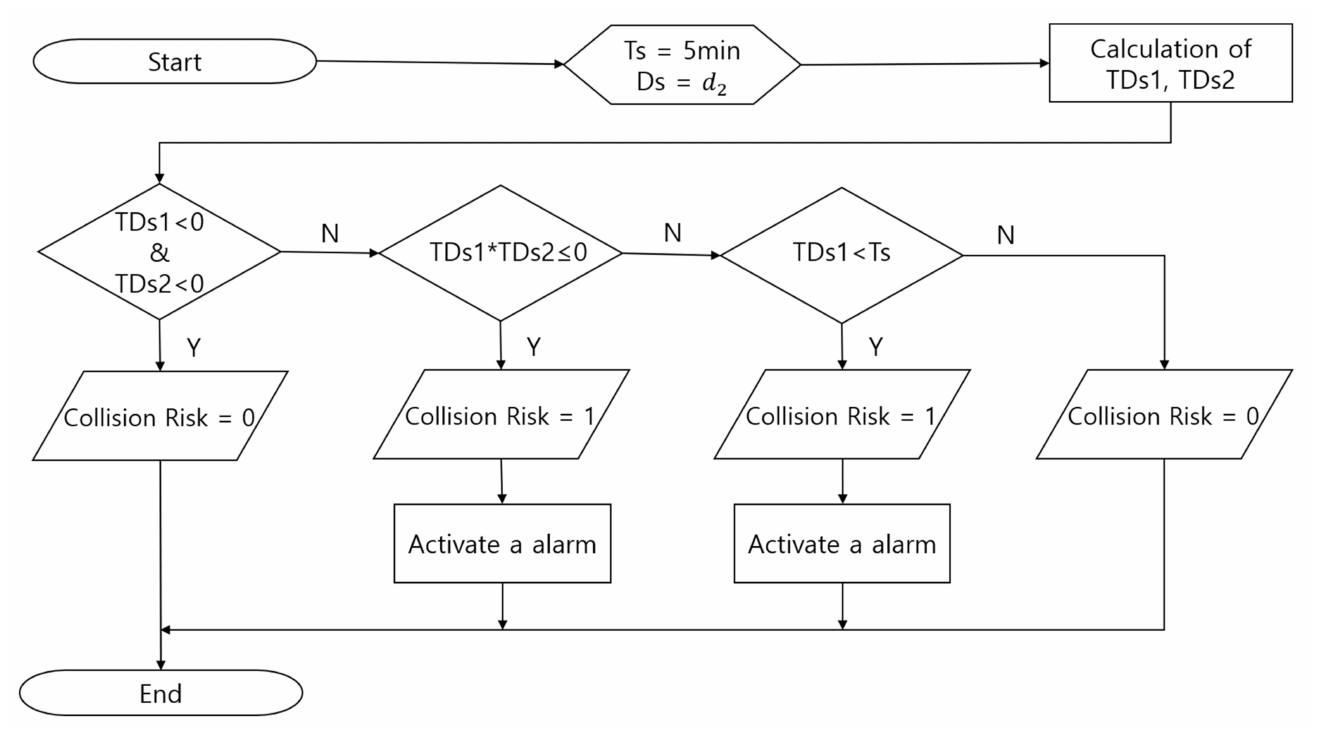
Figure 3. Flowchart for the detection of collision